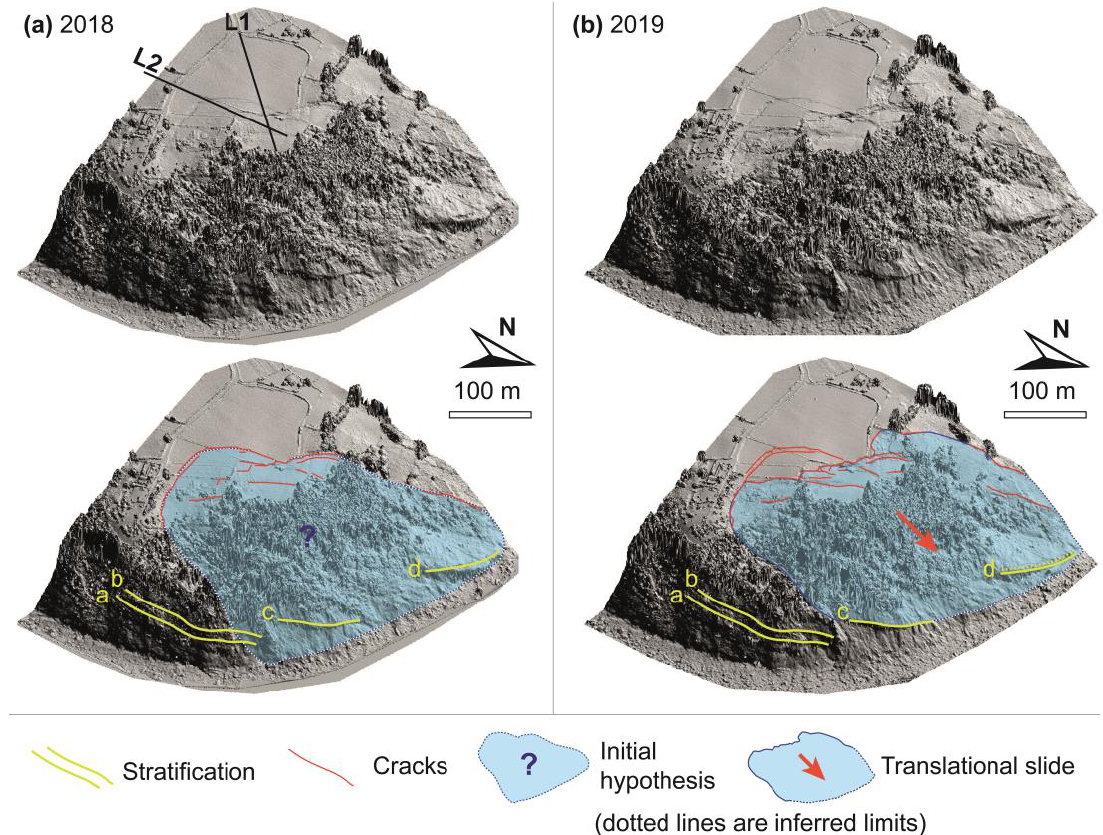
Figure 5. ( a ) Hillshade digital terrain model created from the 2018 UAV, showing the position of electrical tomography lines 1 and 2 ( top ) and the geomorphologic interpretation of the slope, delimiting the potential extent of the unstable portion of the Tazones Lighthouse slope that defines our working hypothesis ( bottom ). The yellow lines indicate the trace of four identifiable sandstone layers of the Lastres Formation to compare their position over time. ( b ) Hillshade digital terrain model created from the 2019 UAV ( top ) showing its geomorphologic interpretation and the limits of the area affected by the complex landslide one year later ( bottom ). Only the trace of layer d shifted downslope, indicating that the rupture surface daylights close to the foot of the cliff to the west, while it intercepts the topographic surface at higher elevations to the east (atop layer c).